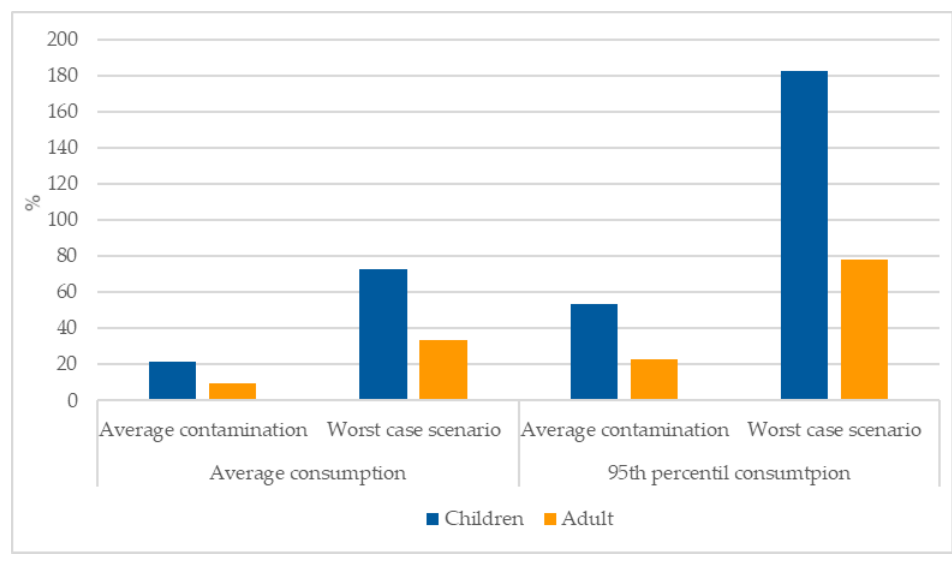
Figure 4. Percentage of the EDI (µg kg −1 bw/day) versus the BMDL 10 (0.3 µg kg −1 bw/day).